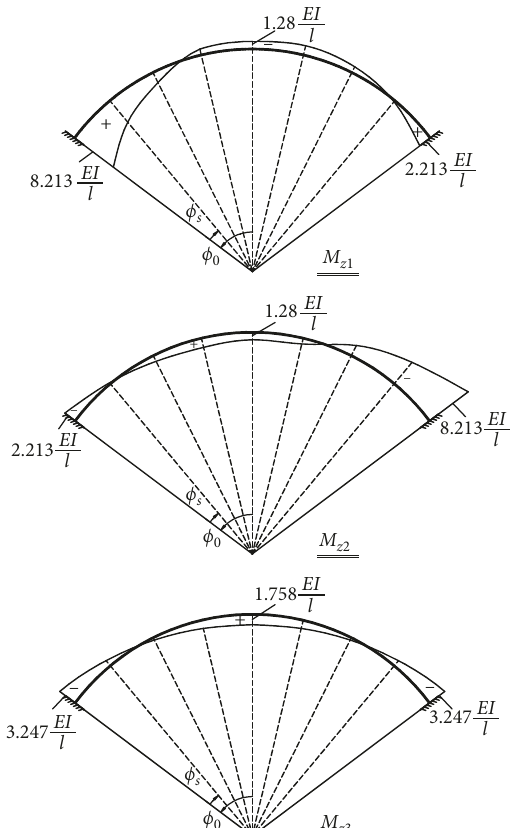
Figure 8: Schematic diagram for the proposed model solving arch with constant section and the corresponding bending moment